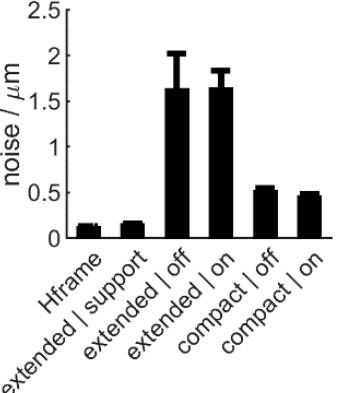
Figure 6. Instrument noise, with single-sided positive error bars indicating standard deviation, in various mounting scenarios: on H-frame and on the robot arm in a compact and extended pose. The arm was supported near the end-e ff ector in one scenario to increase stability. Robot motors were on (energized) or o ff